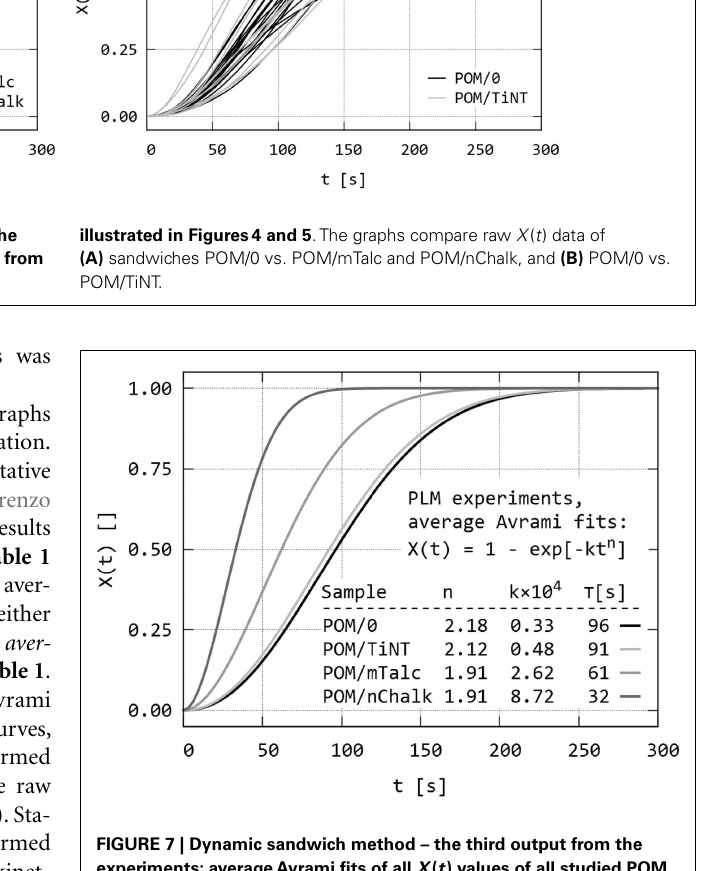
FIGURE 7 | Dynamic sandwich method – the third output from the experiments: averageAvrami fits of all X ( t ) values of all studied POM sandwiches .The fits were calculated from average Avrami parameters ( n , k ), obtained from fitting of raw data illustrated in Figure 6 .The crystallization half-times ( τ ) in the inset table were calculated from ( n , k ) using Eq.